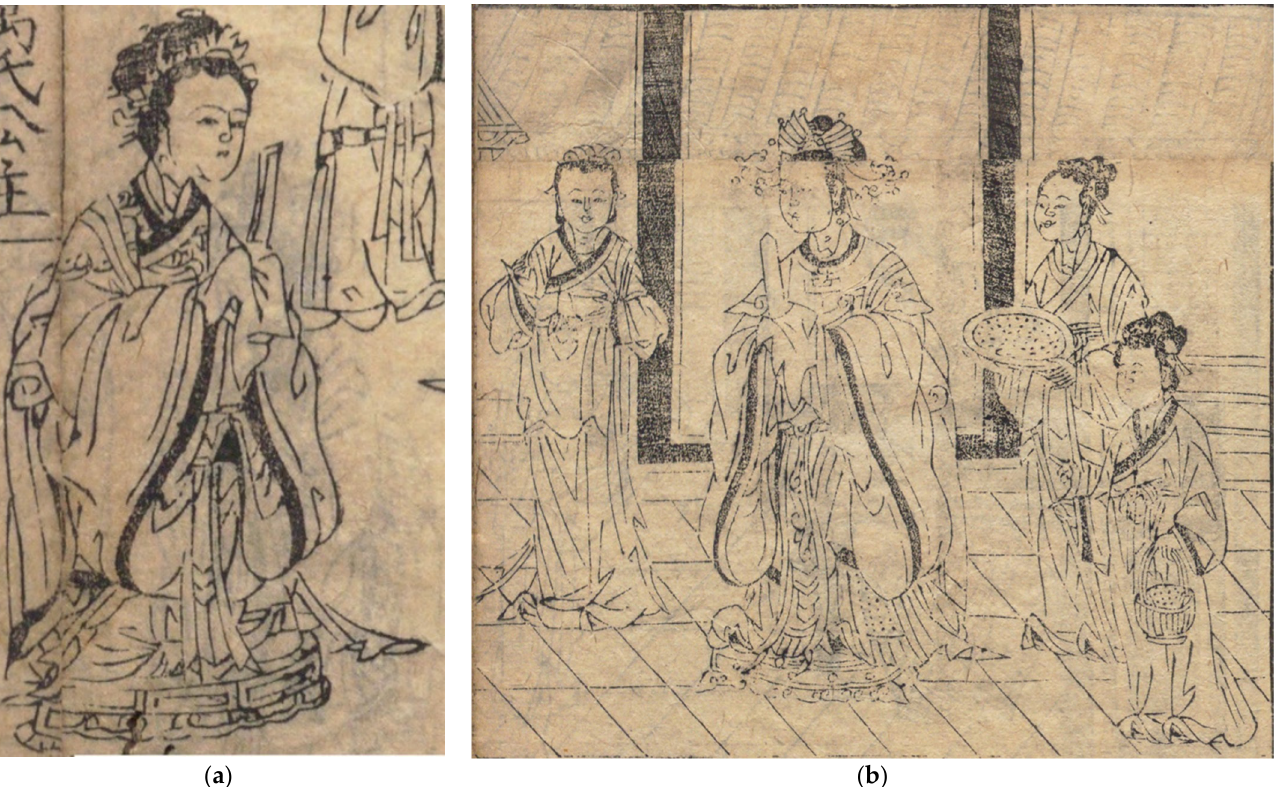
Figure 8. Images of “Xian-Can” in Nong Shu 农书 : ( a ) “Princess Yu of Yuan-Yu woman”. Photo source: Nong Shu 农书 (1304); ( b ) “Xi Ling’s”. Photo source: Nong Shu 农书 (1304).